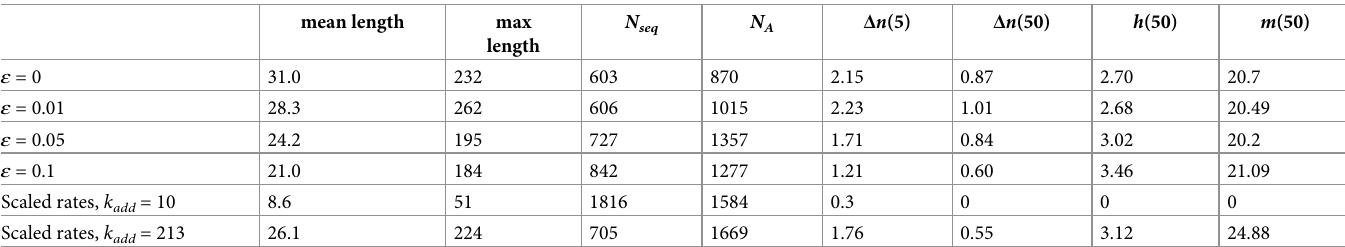
Table 4. Summary of quantities measured in simulations using the equal-error-rates model with four values of ε and the scaled-experimental-rates model. mean